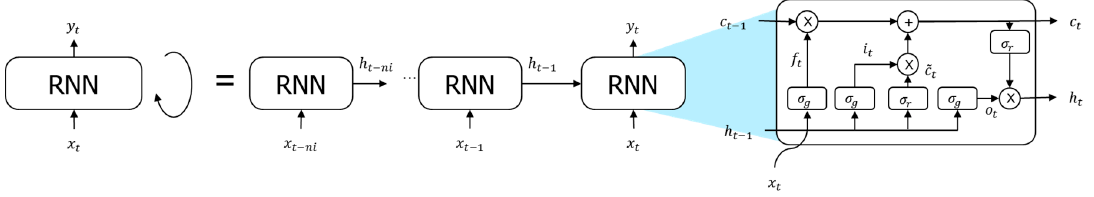
Figure 14. RNN architecture with LSTM cell.